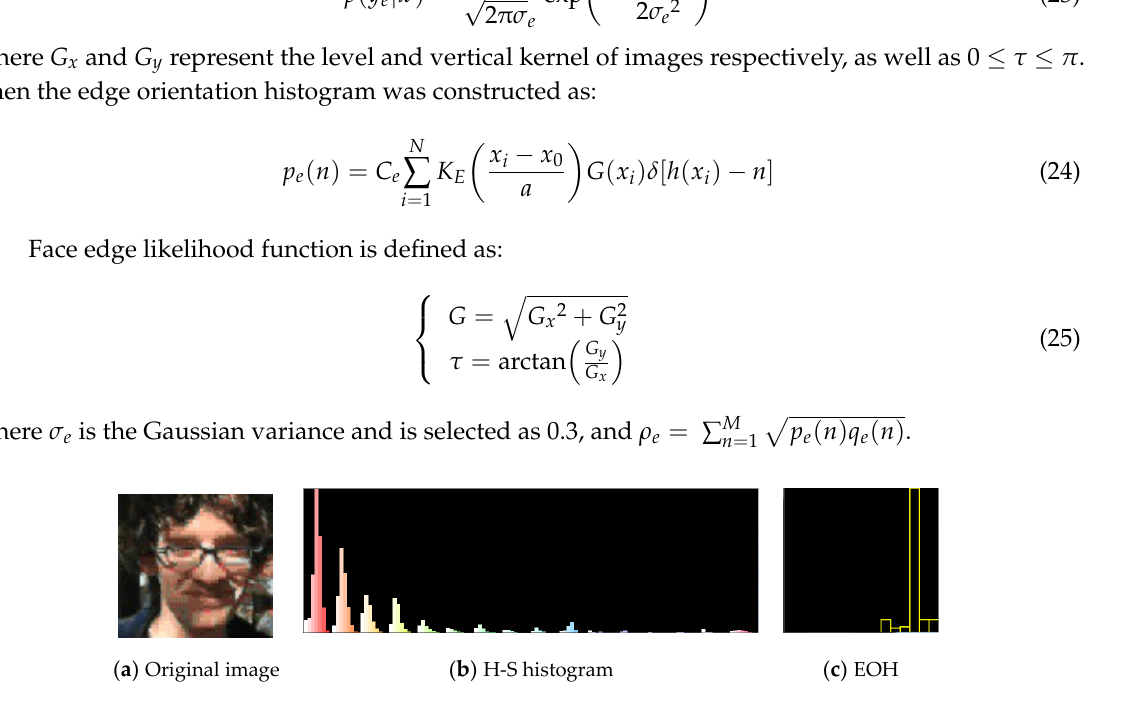
Figure 1. Color histogram and edge orientation histogram.